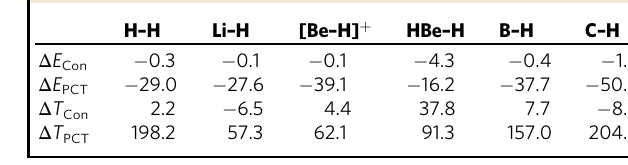
Table 2 Stabilizations for A – H bonds with H contraction orbitals removed (in